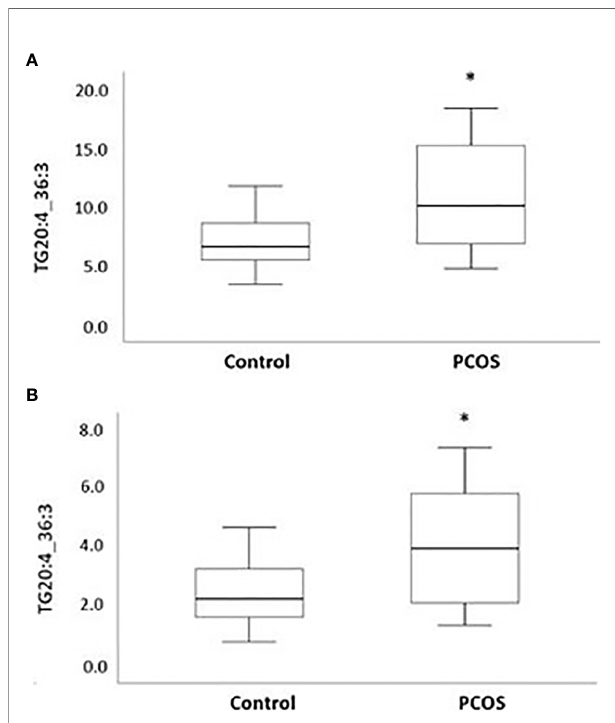
FIGURE 3 | Boxplots representing metabolites increased with PCOS. Differences between controls and PCOS were tested by linear regression. Medians and interquartile range (arbitrary units) are shown for plasma levels of TG20.4_36.3 (A) and TG.18.2_38.6 (B) . (*) FDR level of signi fi cance of ≤ 0.05 was used.